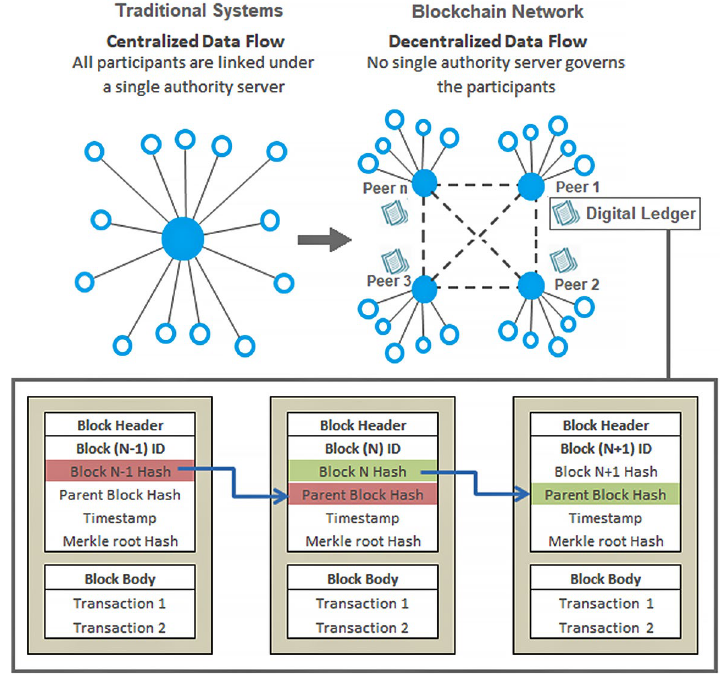
Figure 1. Traditional systems and blockchain